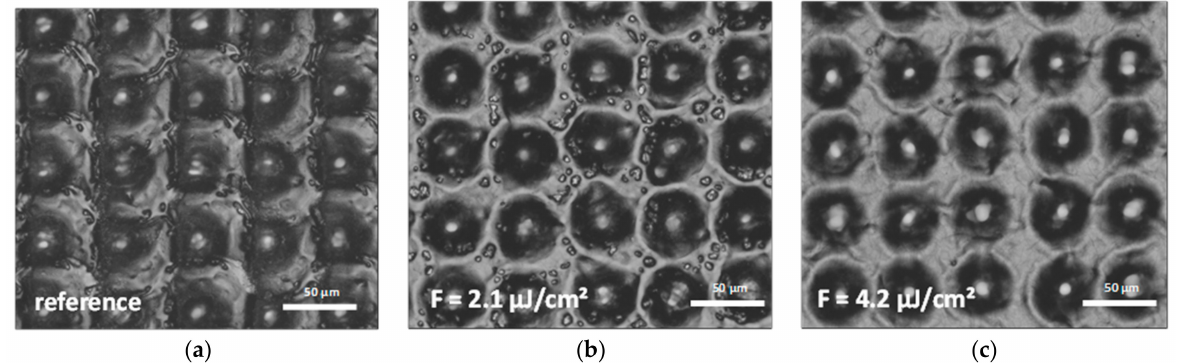
Figure 5. ( a ) Optical microscopy images of a stainless steel surface patterned with DLW with a spot distance of 60 µ m using 500 laser pulses at a pulse duration of 200 ns and a fluence of 0.44 J/cm 2 . ( b ) Patterned surface with an additional laser polish step at a fluence of 2.1 µ /cm 2 and ( c ) 4.2 µ J/cm 2